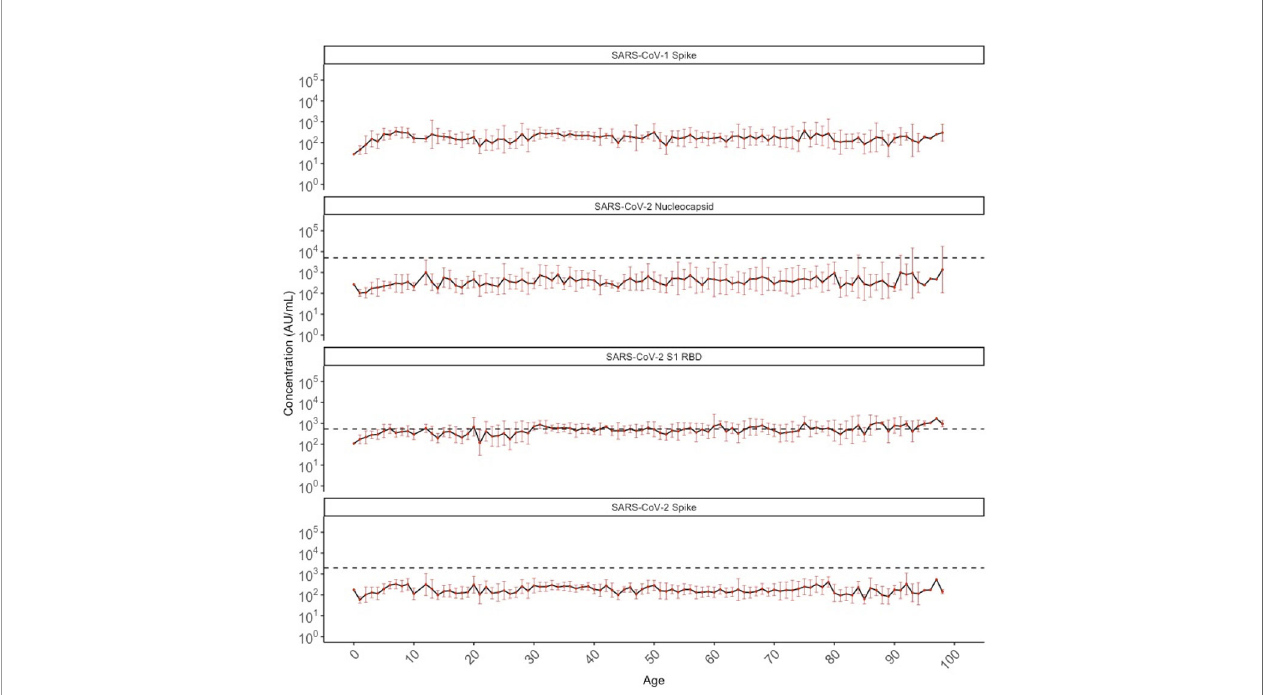
FIGURE 4 | Geometric mean IgG antibody titres against SARS-CoV-1 spike and SARS-CoV-2 nucleocapsid, S1 RBD, and spike in SARS-CoV-2 sero-negative populations (N = 887) by chronological age. SARS-CoV-2 sero-negative populations comprise of all 2013 individuals (N = 407) and SARS-CoV-2 sero-negative individuals from 2020 (N = 480). Red dots indicate the geometric mean antibody titres for each HCoV among all individuals of that age (in years), with the black solid line connecting geometric means. Red bars represent upper and lower standard deviations. Black dashed lines describe the manufacturer provided positivity cutoff for each antigen target. No cutoff is available for SARS-CoV-1